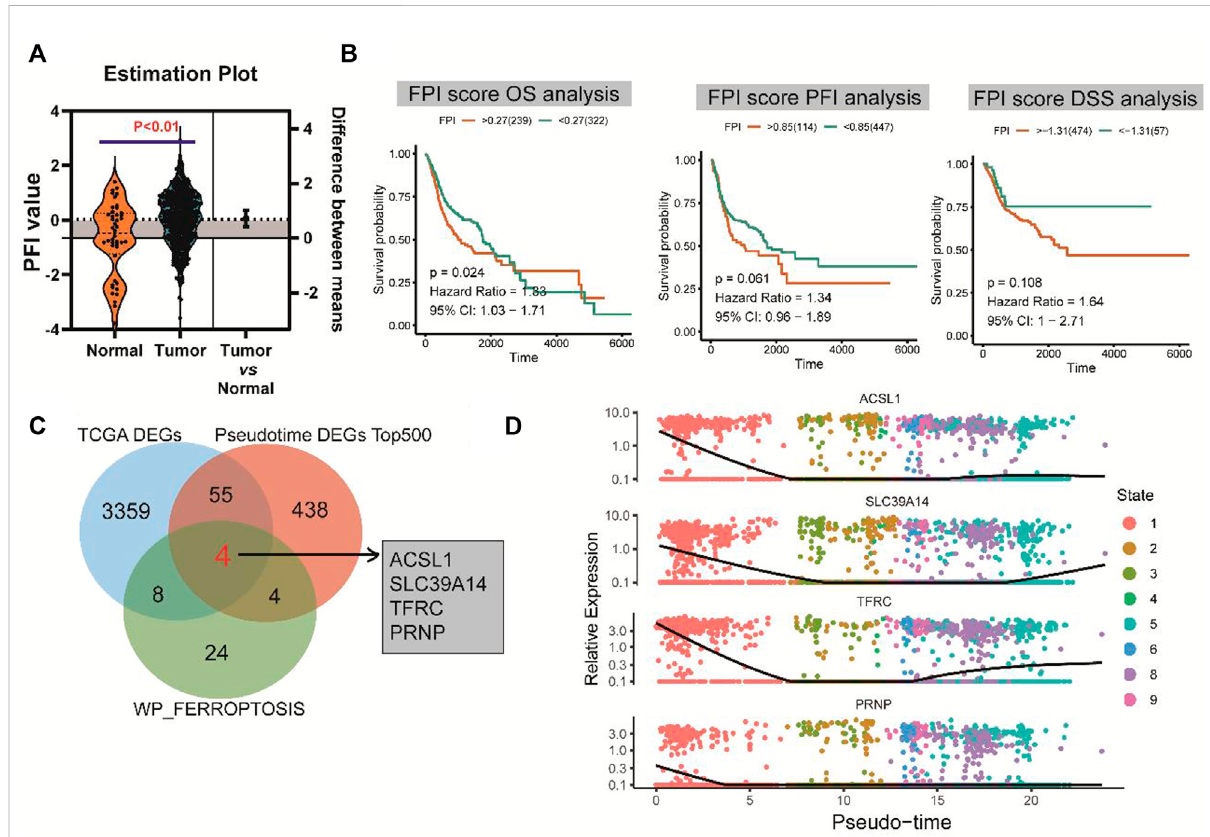
FIGURE 4 FPI and survival analysis and identi fi cation of hub genes. (A) Signi fi cant difference in FPI between HNSCC tumor tissues and normal tissues in TCGA. (B) Signi fi cantassociationofFPIwiththeOSofpatientswithHNSCC,butnotwithPFIorDSS. (C) Fourdifferentiallyco-expressedgenesorhub genes based on the intersection between pseudotime analysis-derived differential genes, TCGA-derived differential genes, and ferroptosis pathway genes. (D) Heatmaps of expression changes of the four hub genes from the early (left) to late stage